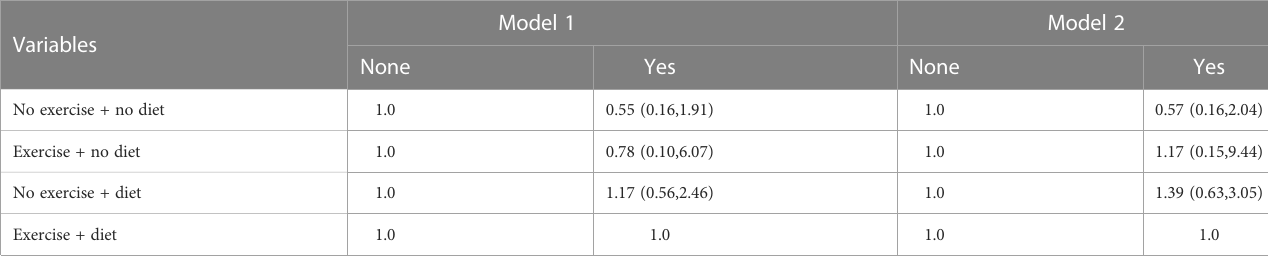
TABLE 13 The correlation between intervene and CVD